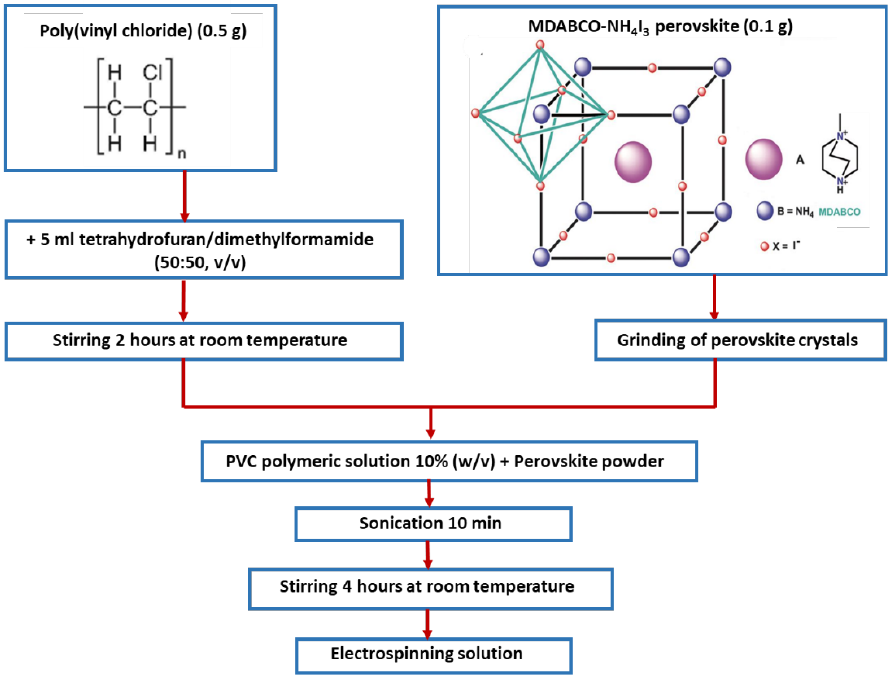
Figure 1. MDABCO-NH 4 I 3 perovskite crystal flow chart for the preparation of MDABCO-NH 4 I 3 @PVC electrospinning solution.